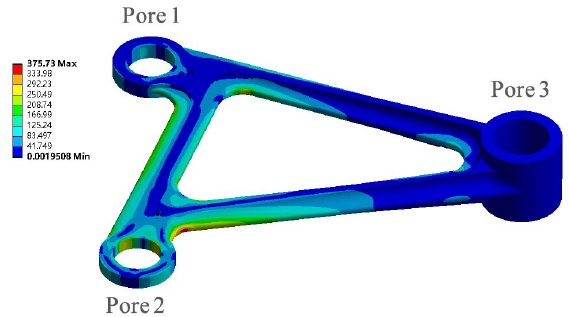
Figure 15. Stress nephogram of rocker arm (Pore 1).